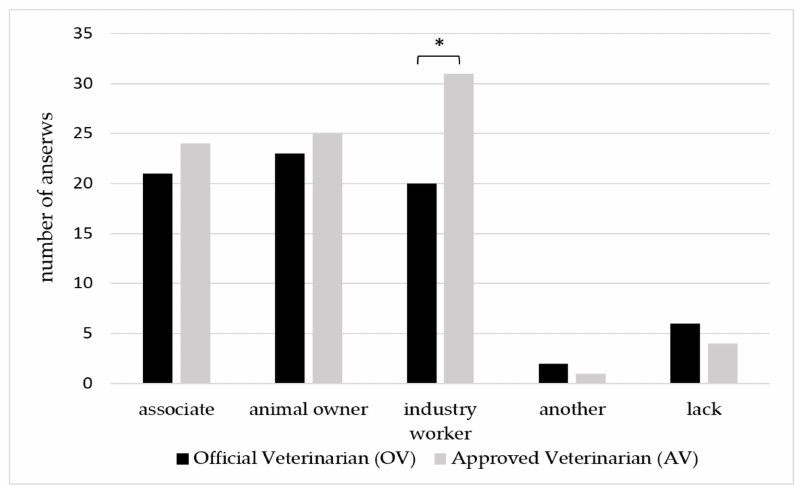
Figure 2. The opposing party of the conflict Veterinary Food Inspectors (VFIs) experience in their work. * Asterisks indicate statistically significant di ff erences ( p < 0.05) between OVs and